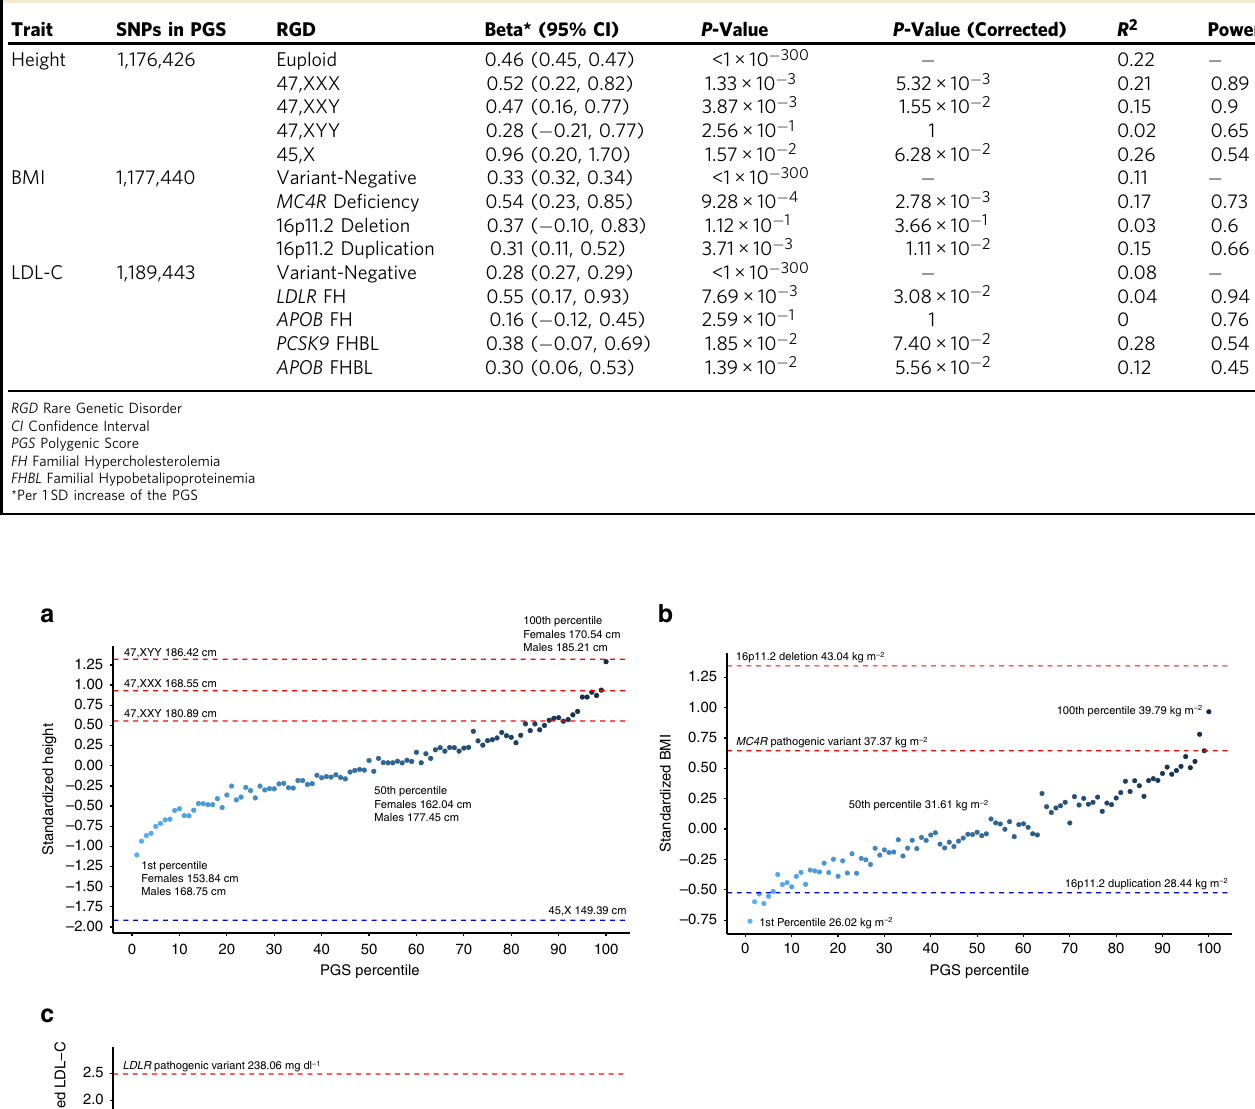
Table 2 Effect size of polygenic scores in patients with rare genetic disorders Trait